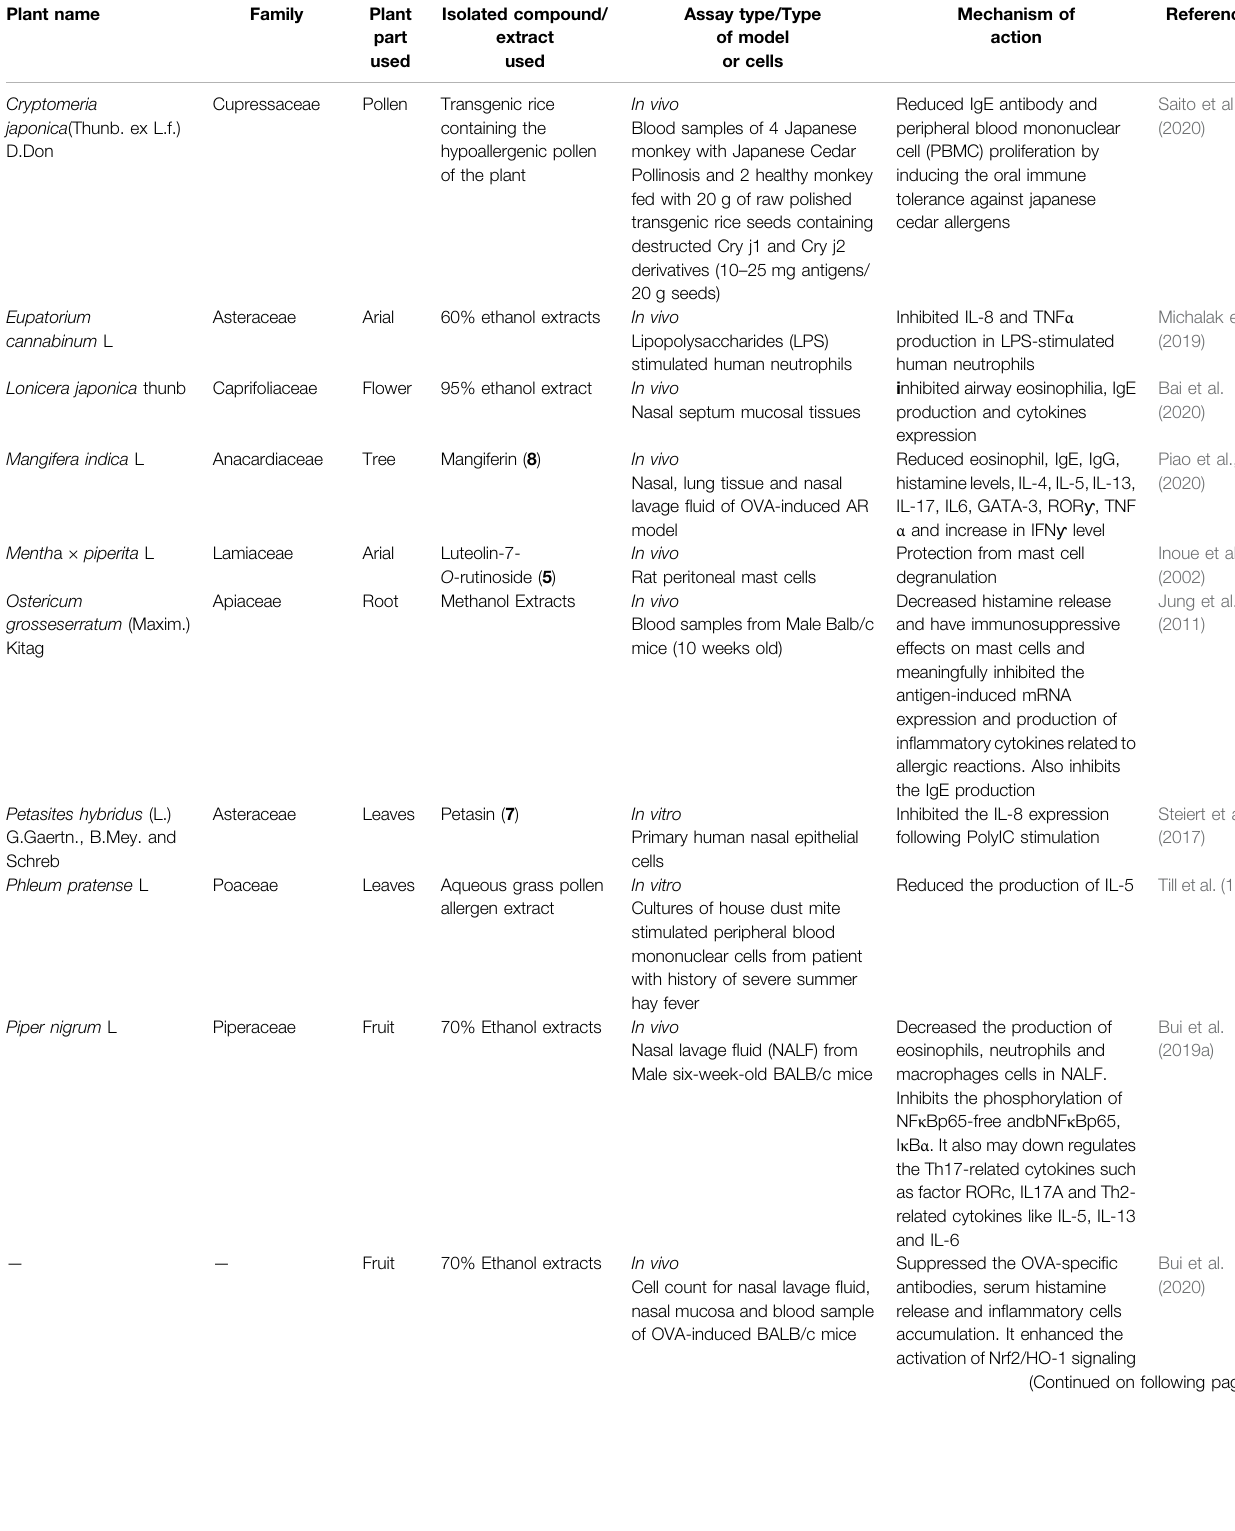
TABLE 1 | ( Continued ) Plants with anti-allergic rhinitis effects in vivo and in vitro